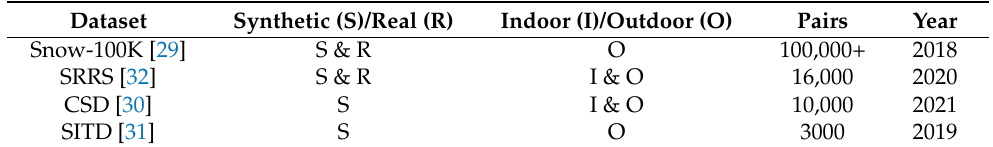
Table 2. Listing of datasets used for the desnowing task. Dataset Synthetic (S)/Real